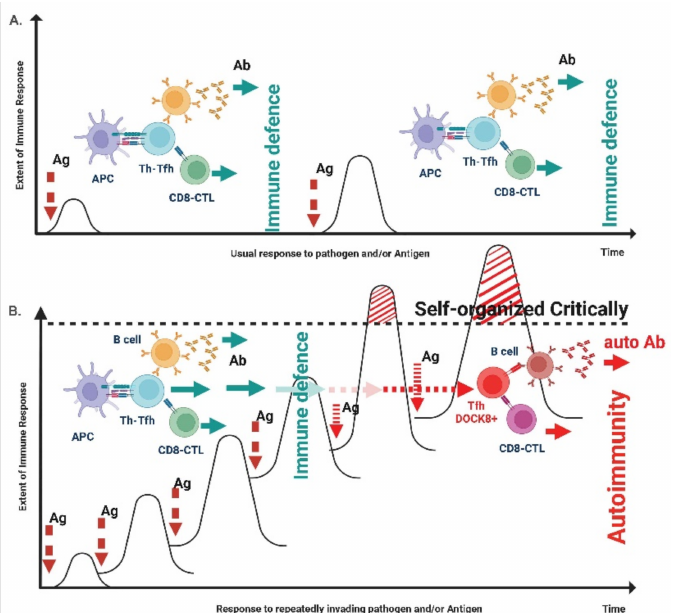
Figure 4. Self-organized Critically Theory. Each system remains in equilibrium when each trigger is modulated, maintaining homeostasis. In image ( A ). we see how the humoral and cellular adaptive immune response is perfectly balanced by a not excessive stimulation by an antigen. The result is an optimal and balanced (regulated) response. In image ( B ). the system undergoes multiple stresses for which it is unable to balance itself, effectively creating an isotype of follicular helper T lymphocytes (DOCK8+, Dedicator of Cytokinesis 8). These lymphocytes give instructions both to the humoral and to the cytotoxic effector compartment, determining the fate of the immune response. In this scenario, the answer is not balanced, but it is rather distorted and leads to an inversion of the adaptive activity, predisposing these lymphocytes to the search of antigens previously encountered, therefore to